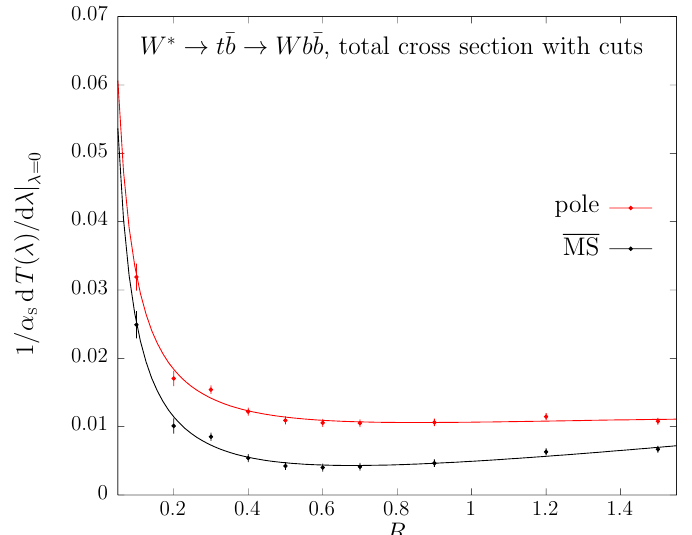
Figure 5 . R dependence of the slope of T ( (cid:21) ) for the inclusive cross section, at (cid:21) = 0, using the pole (red) or the MS mass scheme (black). The solid lines represent (cid:12)ts of parametric form a=R + b + c R + d R 2